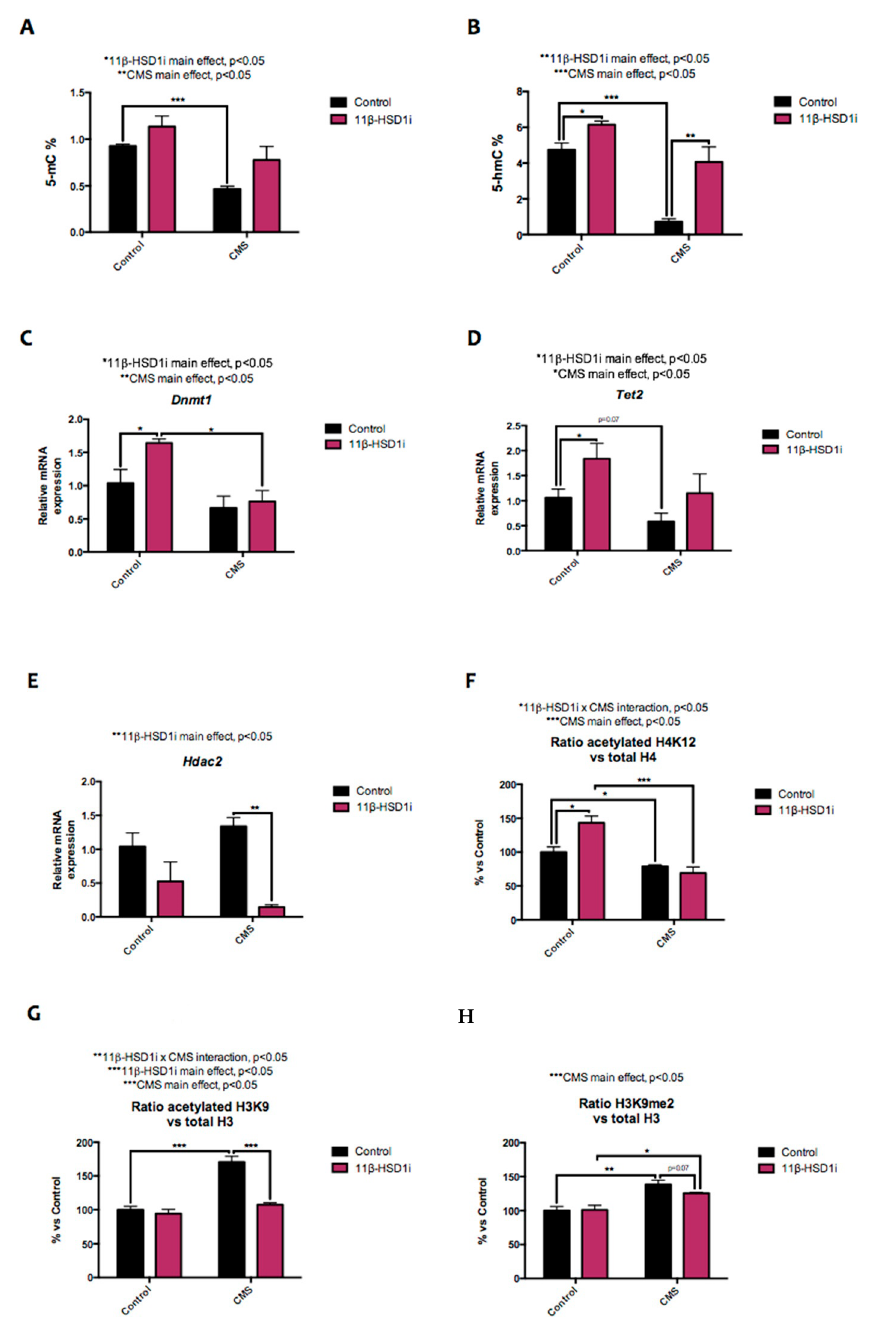
Figure 2. Representative results from epigenetic marks. Global 5-methylated cytosine ( A ) and 5- hydroxymethylated cytosine levels ( B ). Relative gene expression of Dnmt1 ( C ), Tet2 ( D ), and Hdac2 ( E ). Representative Western blot for the ratio of Lys12 acetylated H4 protein levels and quantification ( F ), the ratio of Lys9 acetylated H3 protein levels and quantification ( G ), and the ratio of H3K9me2 protein levels and quantification ( H ). Gene expression levels were determined by real-time PCR. Western blot values in bar graphs are adjusted to 100% for protein levels of SAMP8 Control (Control). Values are mean ± standard error of the mean (SEM) ( n = 6 for each group). 11 β -HSD1 and CMS main effects as well as interactions were determined. * p < 0.05; ** p < 0.01; *** p < 0.001.